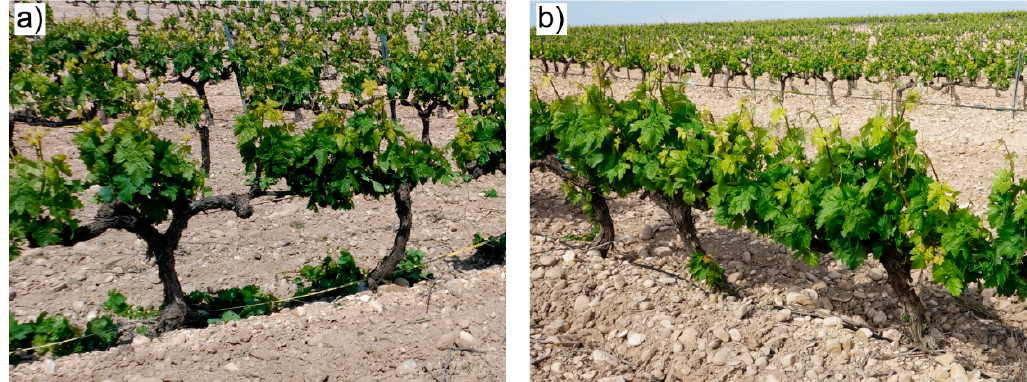
Figure1. ImagesofthevineyardinAzagraaftershootthinning: ( a )shootthinnedvines, ( b Figure 1. Images of the vineyard in Azagra after shoot thinning: a) shoot thinned vines, b) control vines.